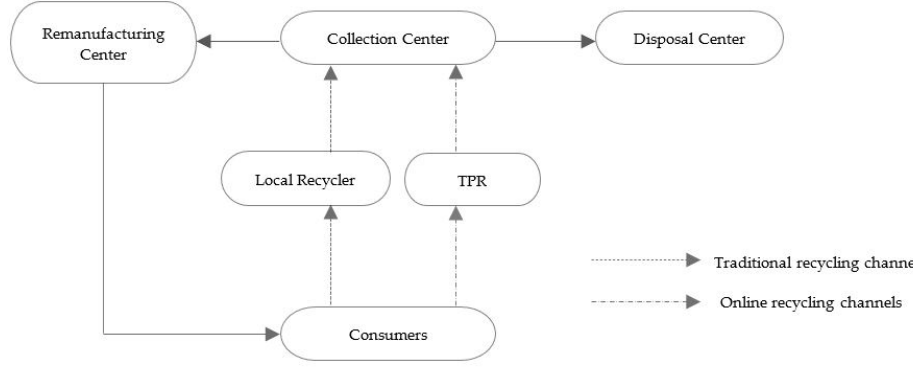
Figure 1. Depiction of the DRSC network.